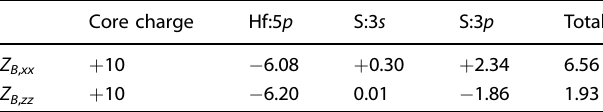
Table 4. A band-by-band decomposition of Born effective charge of Hf in HfS 2 using the integration of Wannier function.